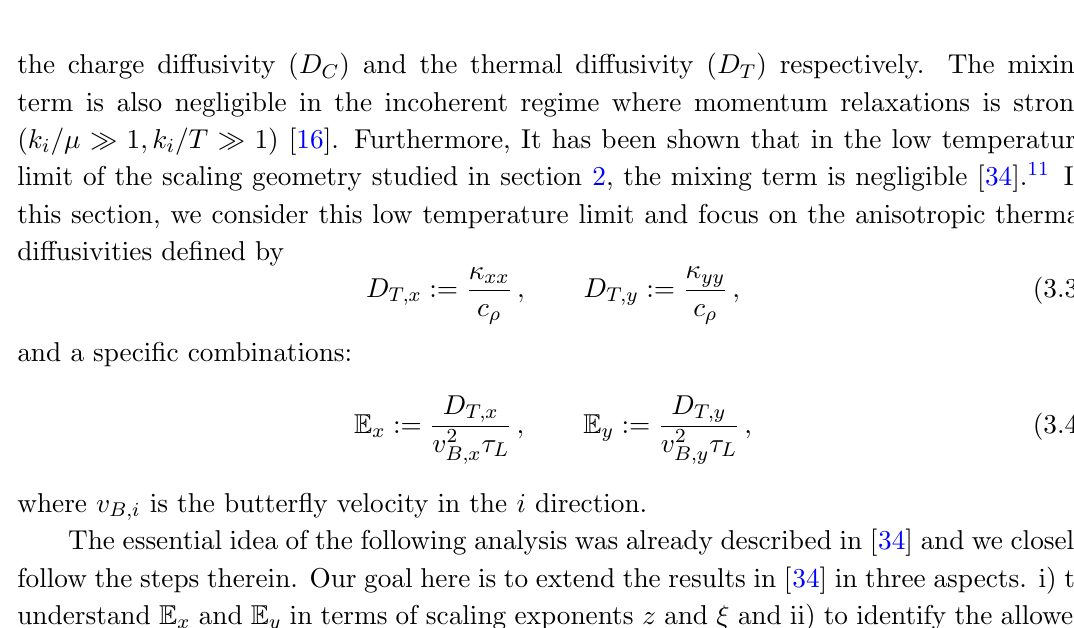
Table 6. Parameter range: Class II-ii, V 0 >